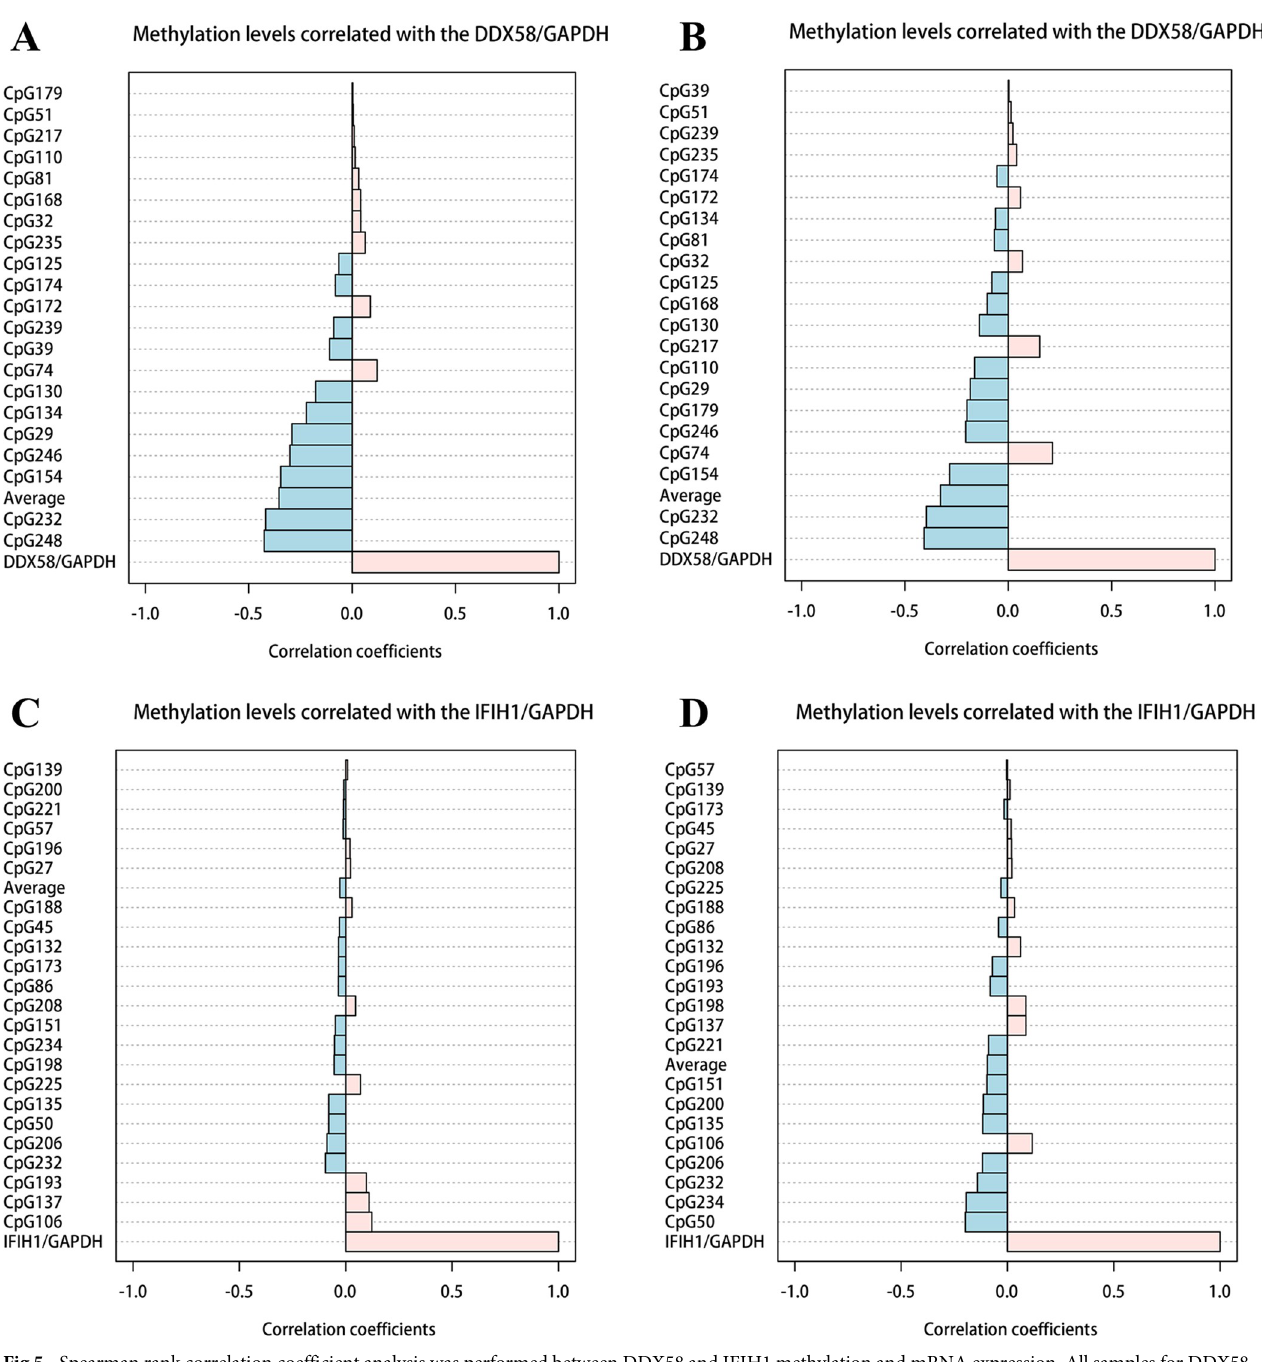
Fig 5. Spearman rank correlation coefficient analysis was performed between DDX58 and IFIH1 methylation and mRNA expression. All samples for DDX58 (A). EV71-HFMD patients for DDX58 (B). All samples for IFIH1 (C). EV71-HFMD patients for IFIH1 (D).